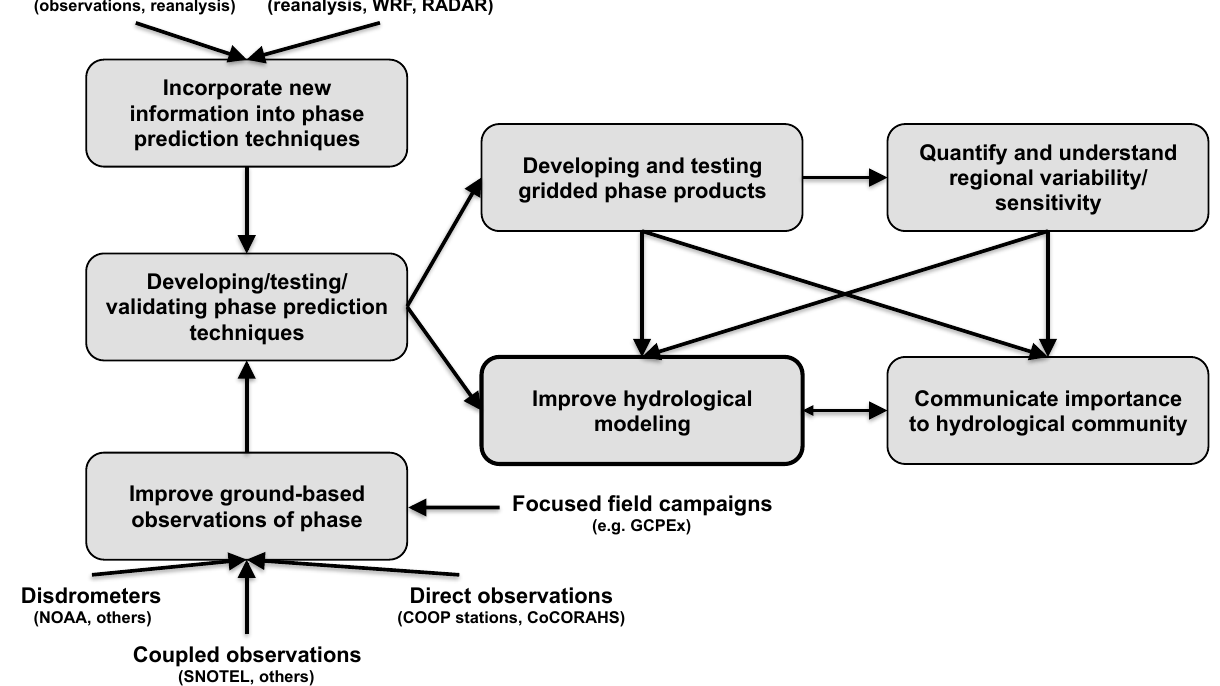
Figure 4. Conceptual representation of the research gaps and workflows needed to advance PPM and improve hydrological